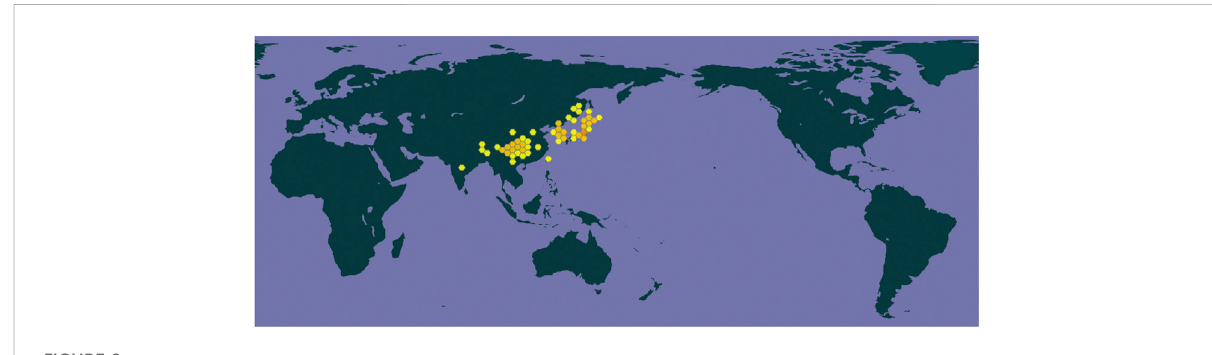
FIGURE 2 The origin of Gastrodia elata blume